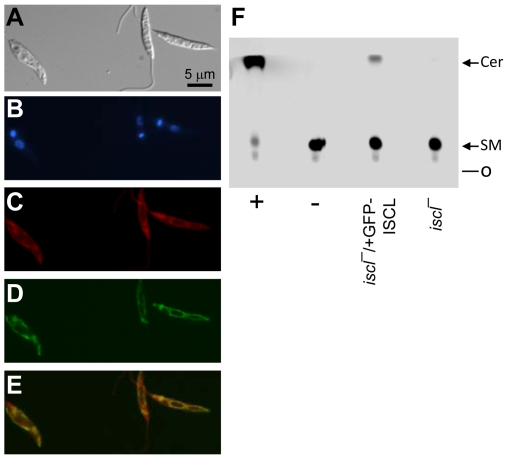
Cellular localization of GFP-tagged ISCL.(A–E) Log phase WT [pXG-GFP-ISCL] parasites were stained with MitoTracker Red580 and subjected to fluorescence microscopy. (A) DIC; (B) Hoechst staining; (C) MitoTracker staining; (D) GFP fluorescence; (E) Merge of C and D. (F) GFP-ISCL is functional. Whole cell lysates from iscl− or iscl− transfected with pXG-GFP-ISCL were tested for neutral SMase activity as described and a representative TLC image is shown. Positive control (+): 0.1 unit of B. cereus SMase; negative control (−): boiled WT lysate.